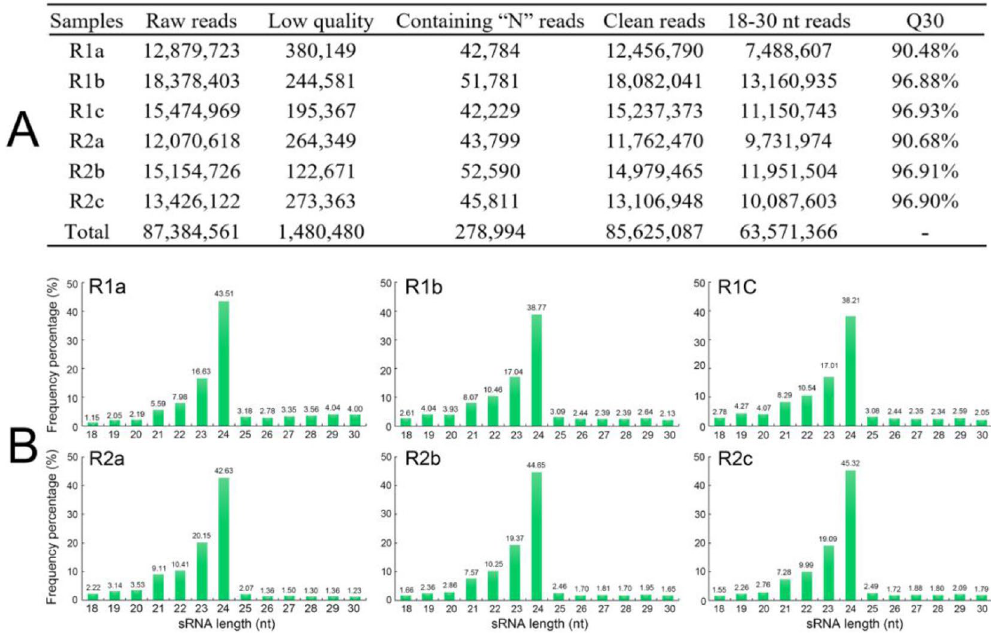
Figure 2. Summary statistics of sRNAs ( A ) and length distribution of clean reads ( B ) between R1 and R2 samples.